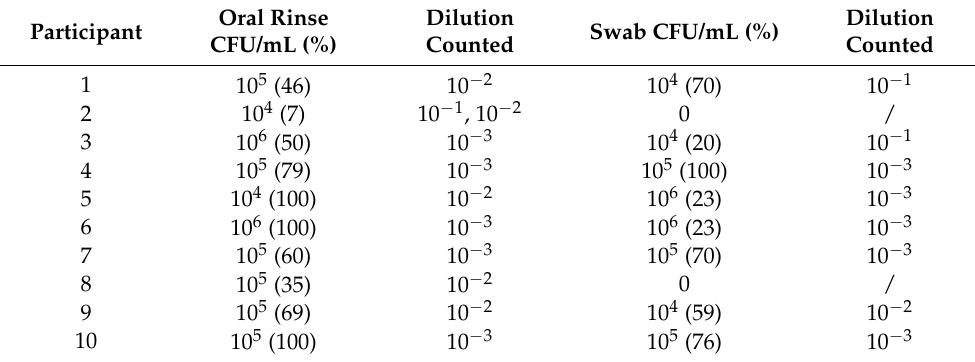
Table 2. Number of colonies isolated from oral rinse and swab samples on the LBVT-SNR plates without azithromycin (expressed as CFU/mL) and the proportion of colonies with an azithromycin MIC higher than 2 µ g/mL (%). Behind each sample type, the dilution that was used for colony counting is shown (resulting in 20–200 colonies after